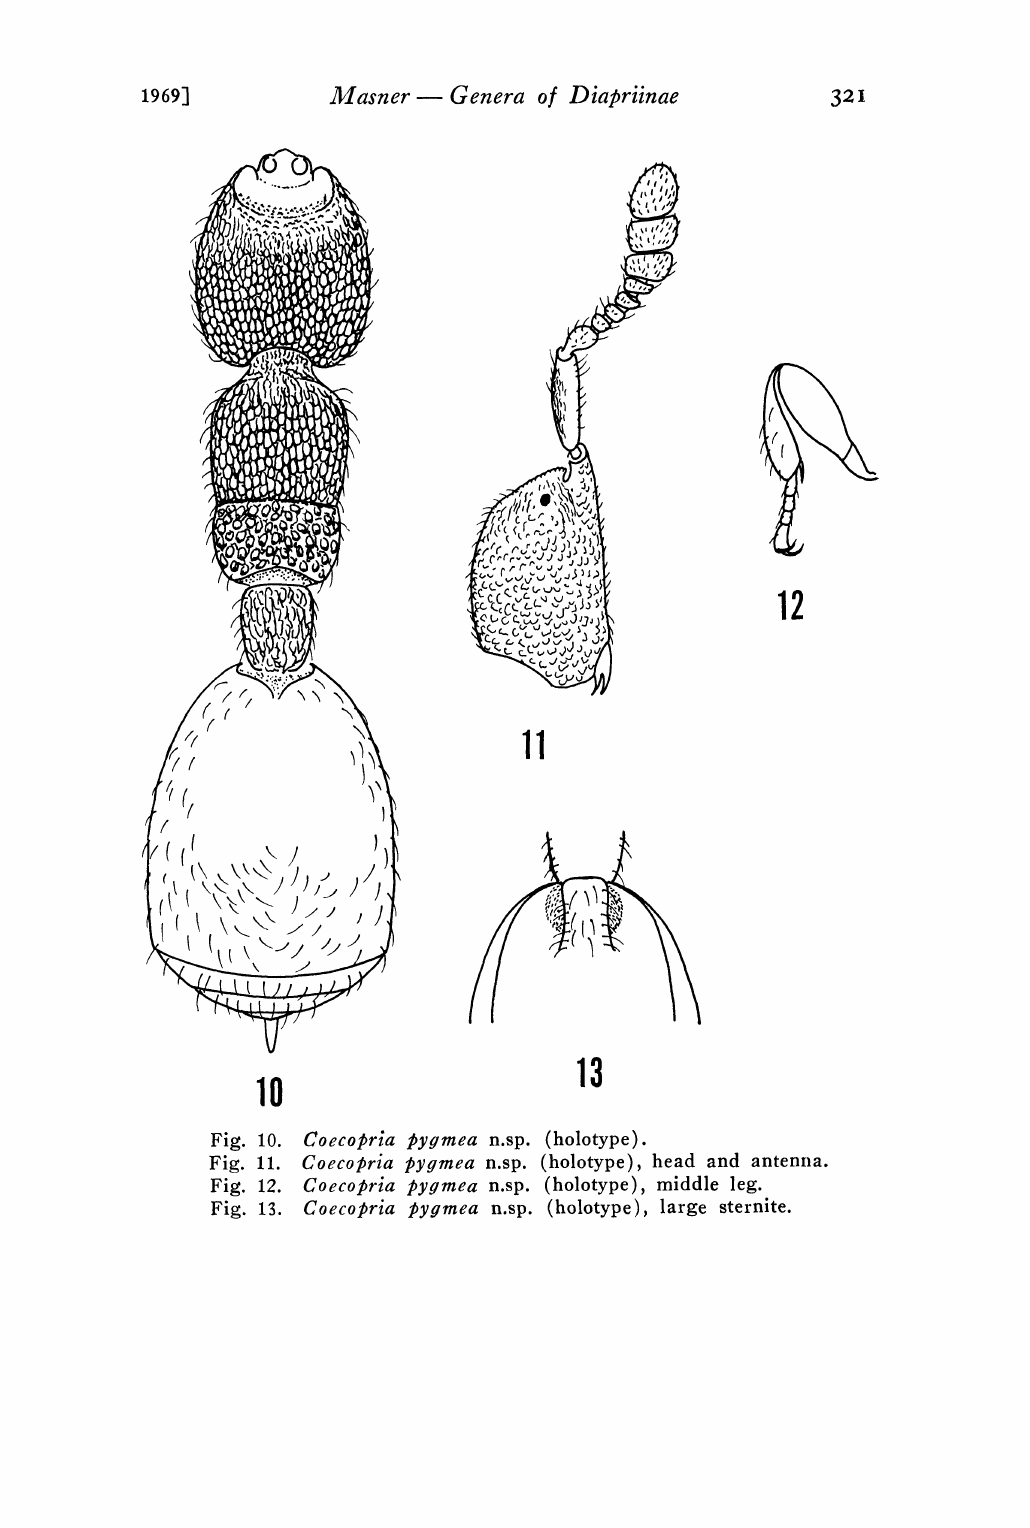
Coecopria pygmea n.sp. (holotype). Fig. 10. Coecopria pygmea n.sp. (holotype), head and antenna. Fig. 11. Coecopria pygmea n.sp. (holotype), middle leg. Fig. 12. Coecopria pygmea n.sp. (holotype), large Fig. 13.